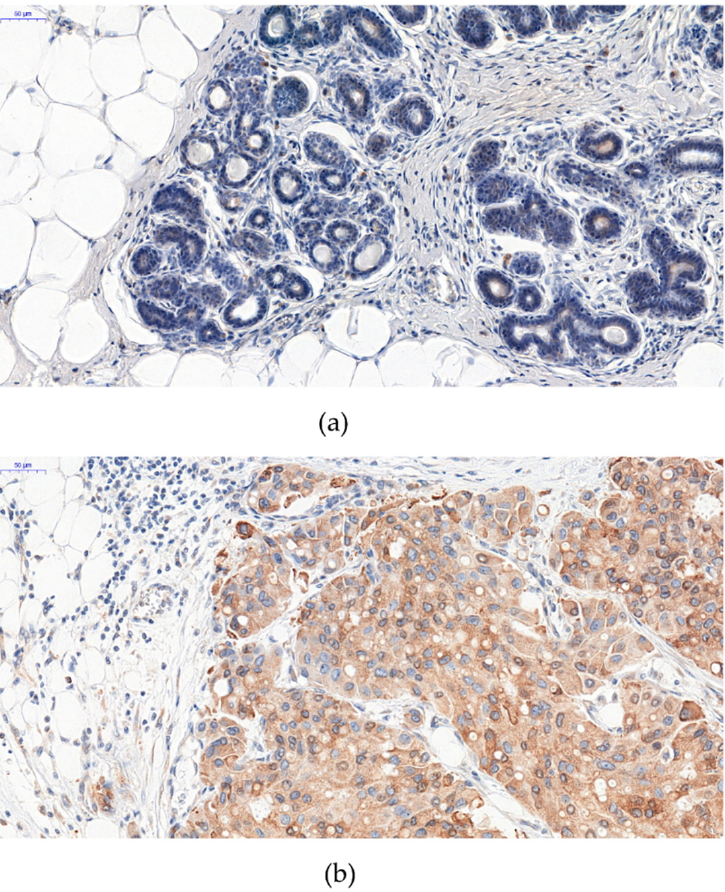
Figure 1. Expression of NUCB2/NESF-1 in mastopathy ( a ) and invasive ductal breast carcinoma ( b ) NUCB2/NESF-1 was located in the cytoplasm of breast cancer cells. Original magnification: 200 × .